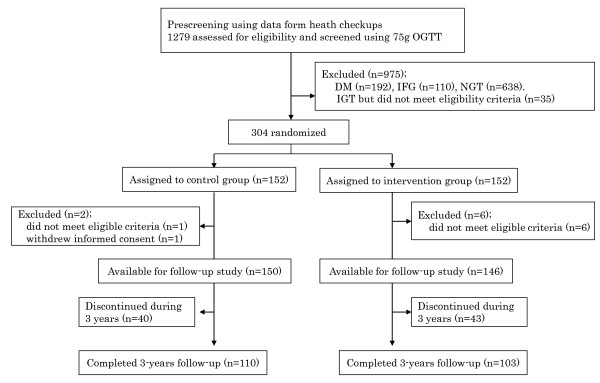
Recruitment, random assignment, and 3 - year follow-up of study subjects. DM: diabetes mellitus, IFG: impaired fasting glucose, NGT: normal glucose tolerance